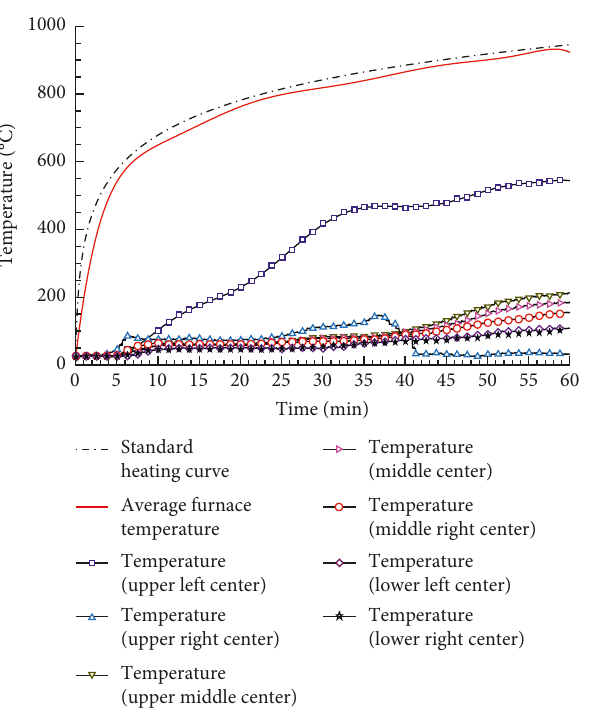
Figure 16: Time-temperature chart for the specimen in Test 2.